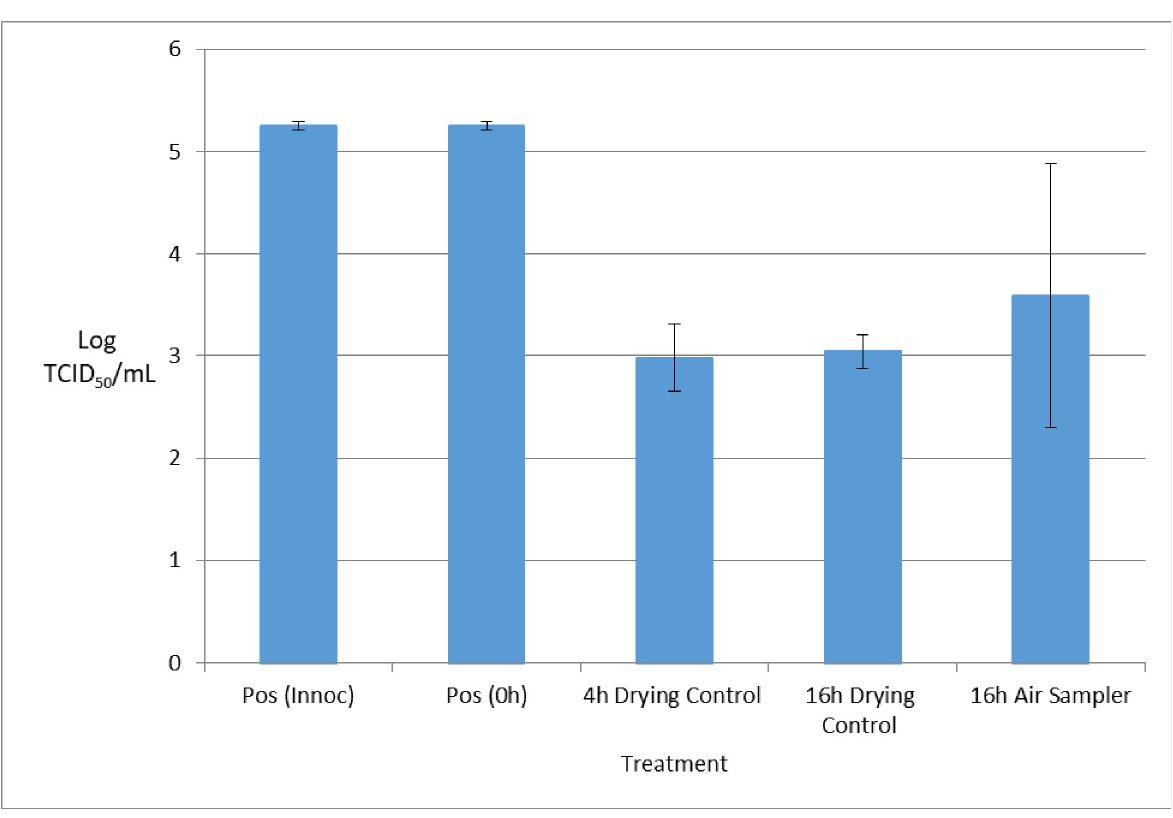
Fig 1. Impact of air sampling on VSV recovery from gelatin